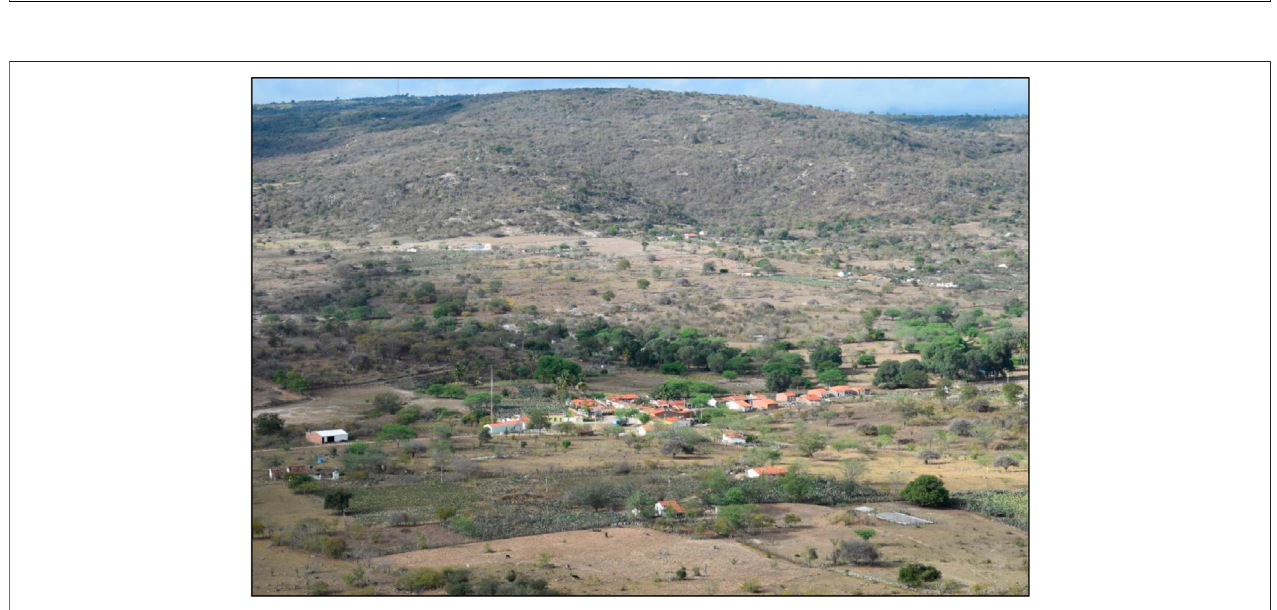
FIGURE3| LandscapeoftheCarãoruralcommunity,locatedintheAltinhoMunicipality(PernambucoState,semiaridregionofNortheasternBrazil).Photo:Regina C. S. Oliveira.